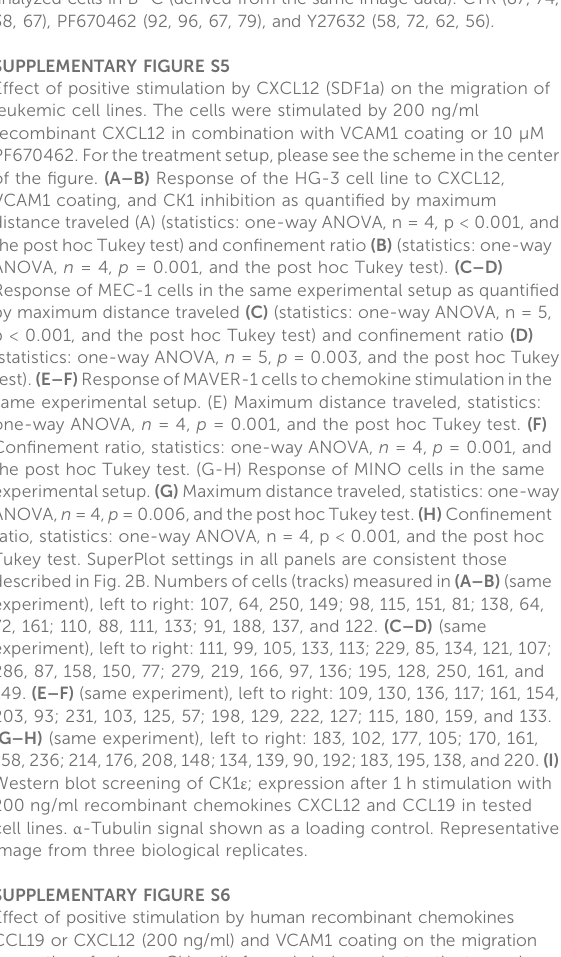
SUPPLEMENTARY TABLE S1 Table of antibodies used for fl ow cytometry analysis. SUPPLEMENTARY TABLE S2 FIJI macros used for pre-processing of the time-lapse data for tracking analysis and for segmentation of cellular outlines from CellBrite data. SUPPLEMENTARY TABLE S3 R scripts for the calculation of the mutual distances between identi fi ed vesicles (both